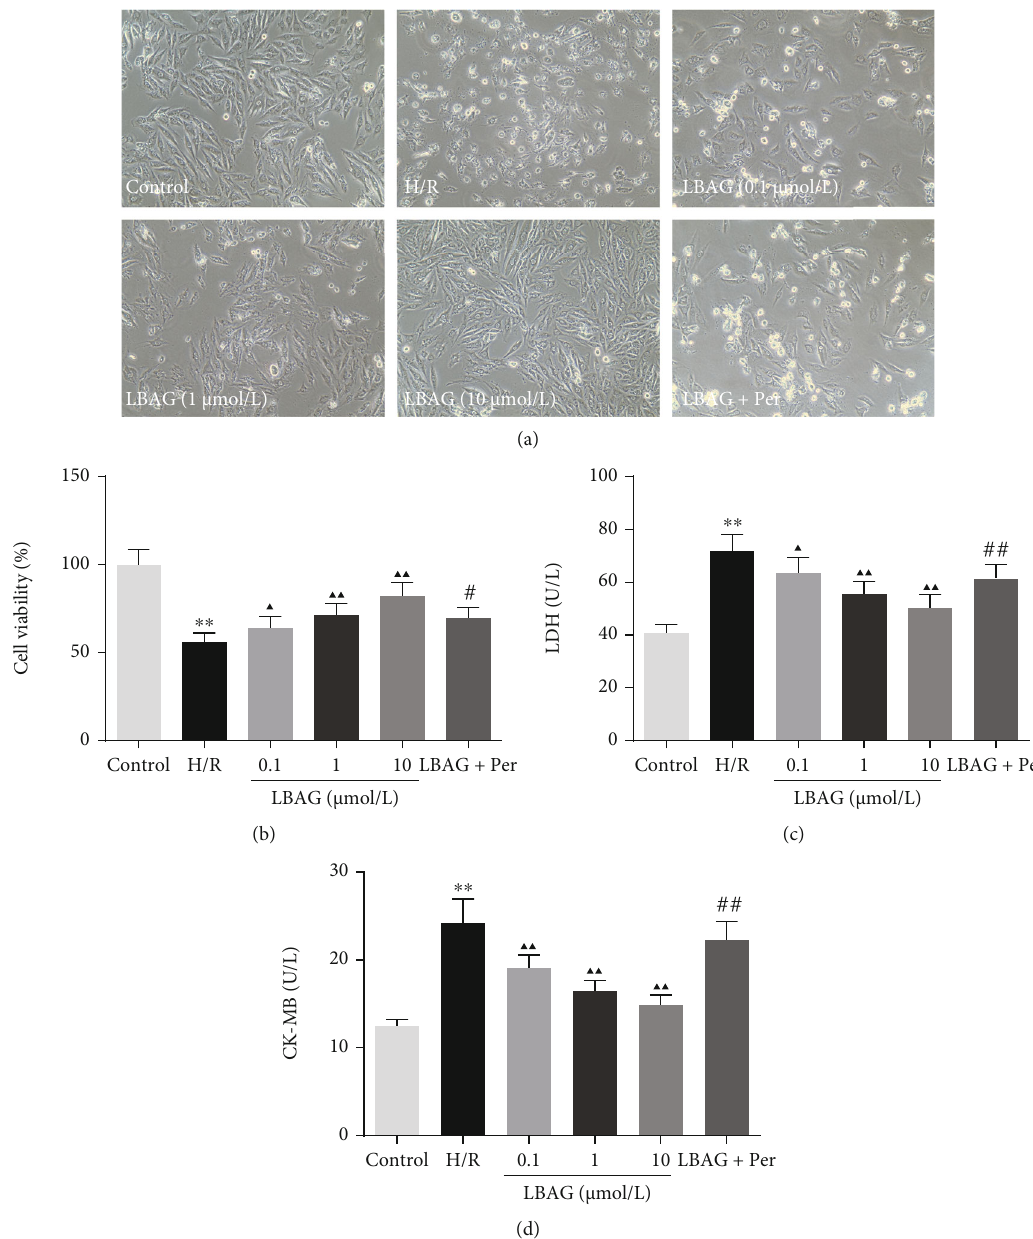
Figure 6: E ff ect of LBAG on the cell injury of H/R model in H9c2 cells. (a) Cell morphology of H/R-induced H9c2 cells treated with LBAG was photoed by optical microscopy. (b) Cell viability of the H/R injury model treated with LBAG was assessed by CCK-8 assay. (c, d) The LDH and CK-MB levels in the culture supernatant of H/R-injured H9c2 cells were detected using ELISA. ∗ P < 0 : 05 and ∗∗ P < 0 : 01 vs. control group. ▲ P < 0 : 05 and ▲▲ P < 0 : 01 vs. H/R group. # P < 0 : 05 and ## P < 0 : 01 vs. 10 μ mol/L LBAG